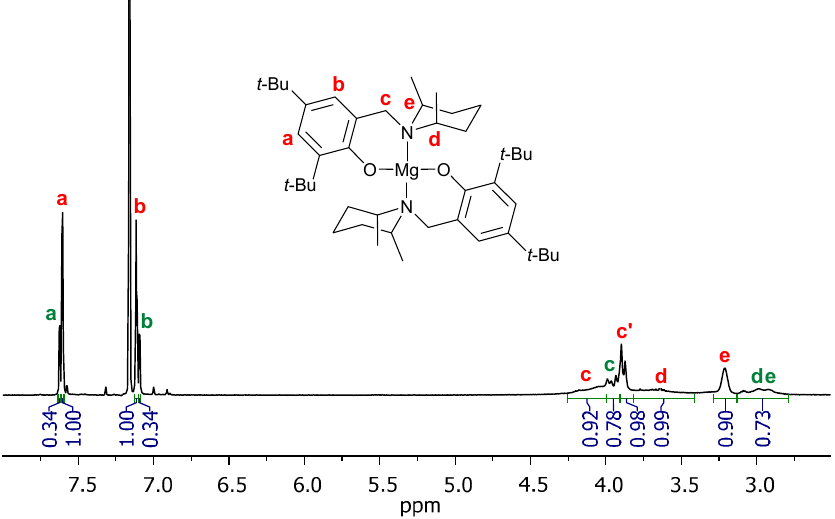
Figure 5. Fragment of 1 H NMR spectrum of (L dmp ) 2 Mg (C 6 D 6 ). Major form: red, minor form: green.